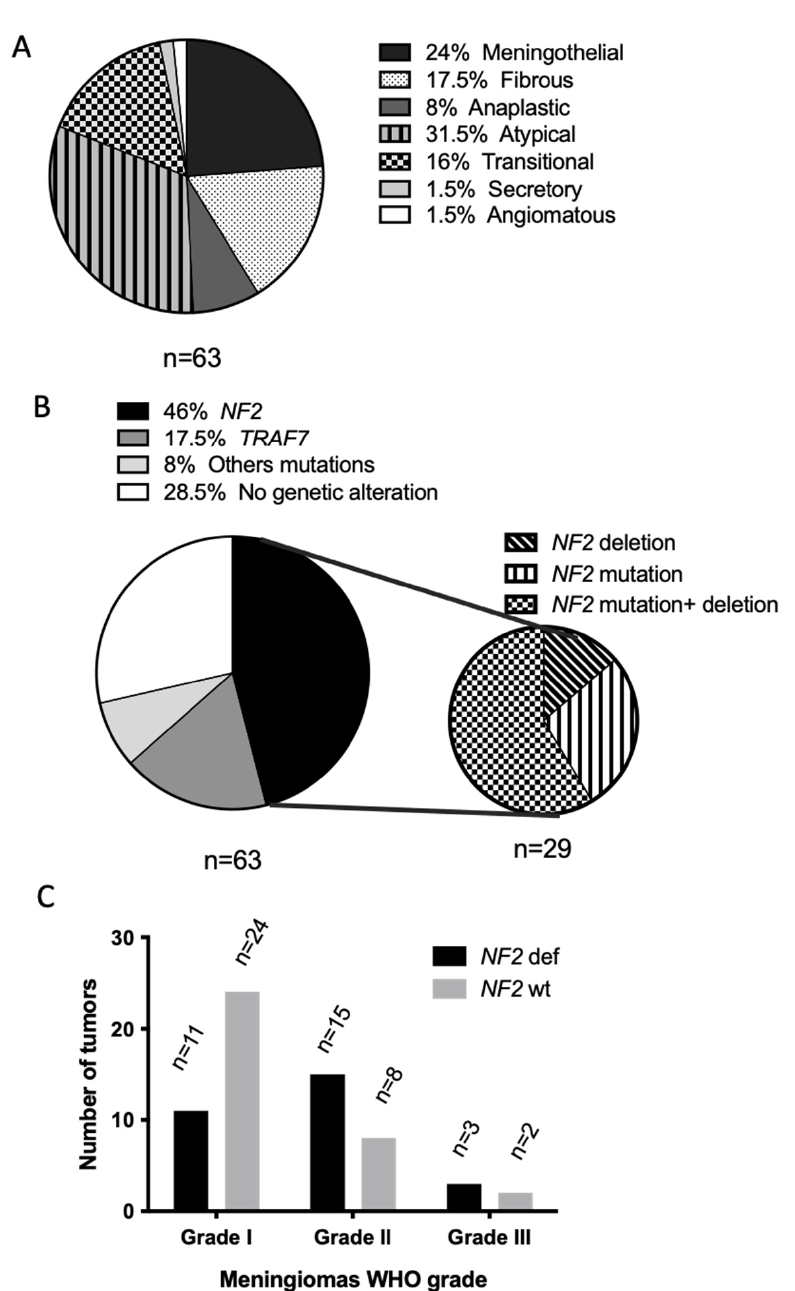
Figure 3. Histopathological ( A ), genomic ( B ) and 2021 WHO grade ( C ) characteristics of the 63 meningiomas. NF2 wt: NF2 wild-type; NF2 def: NF2 deficiency meaning tumors with NF2 alterations, mutation, deletion or both.